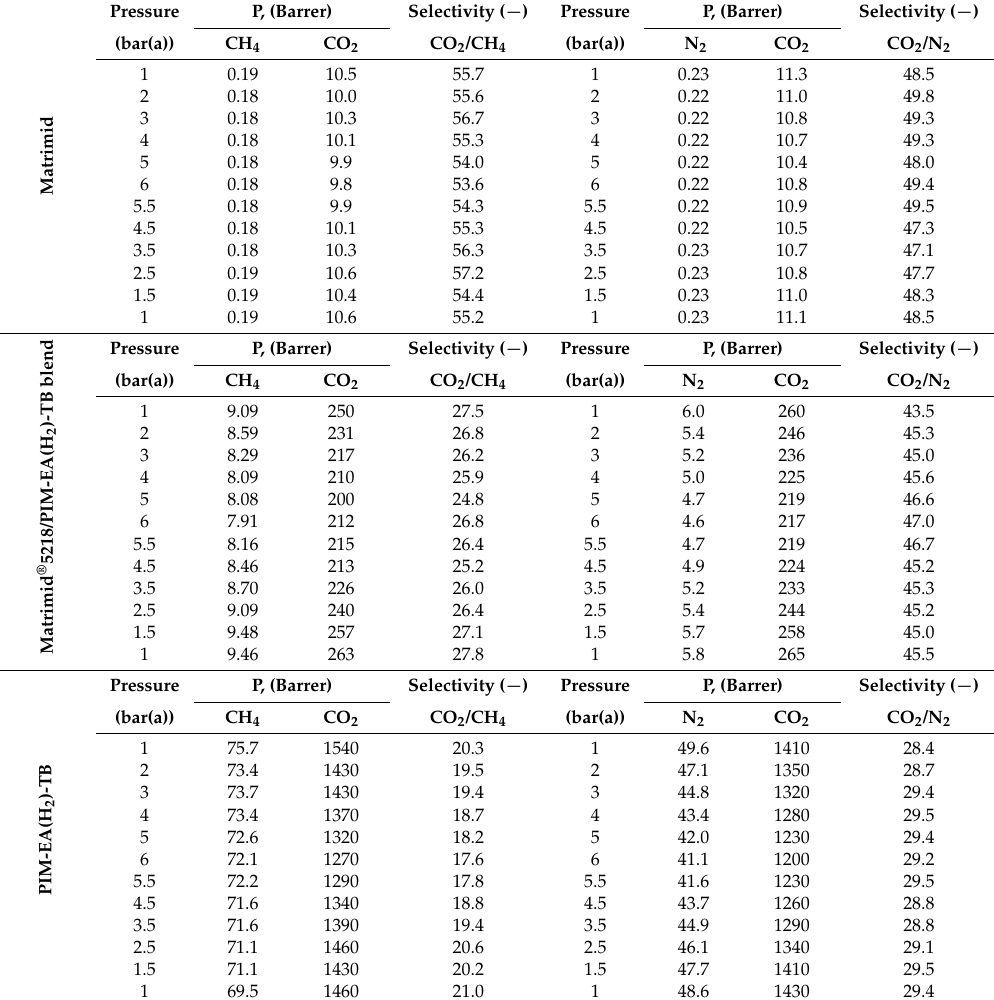
Table A1. Mixed gas permeabilities and selectivity for Matrimid, Matrimid ® 5218/PIM-EA(H 2 )-TB blend and PIM-EA(H 2 )-TB membranes using the binary mixture CO 2 /CH 4 (35/65) vol % and the binary mixture CO 2 /N 2 (15/85) vol